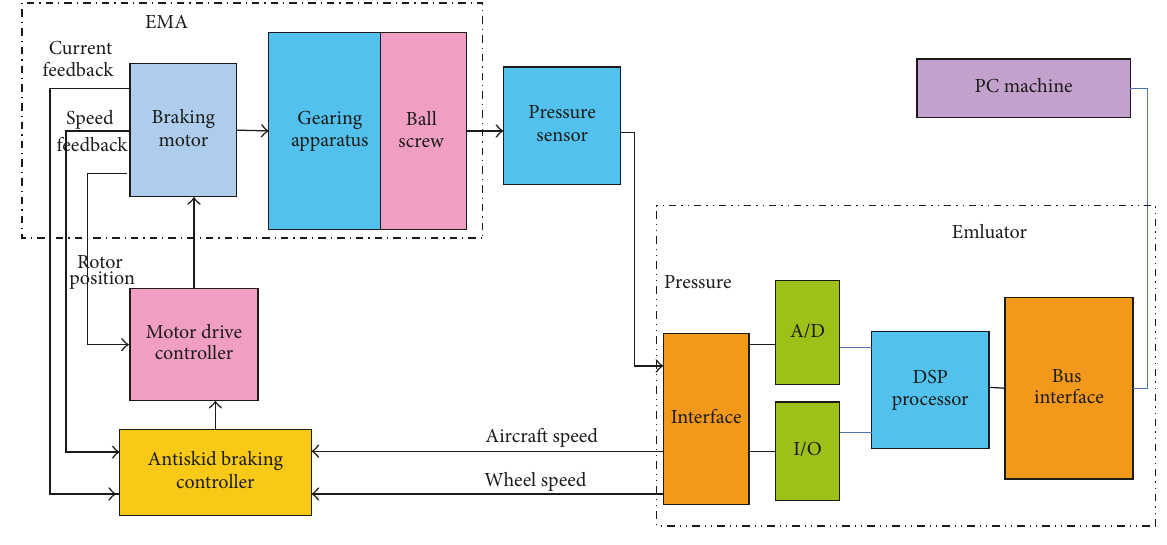
Figure 1: The structure of aircraft braking system.